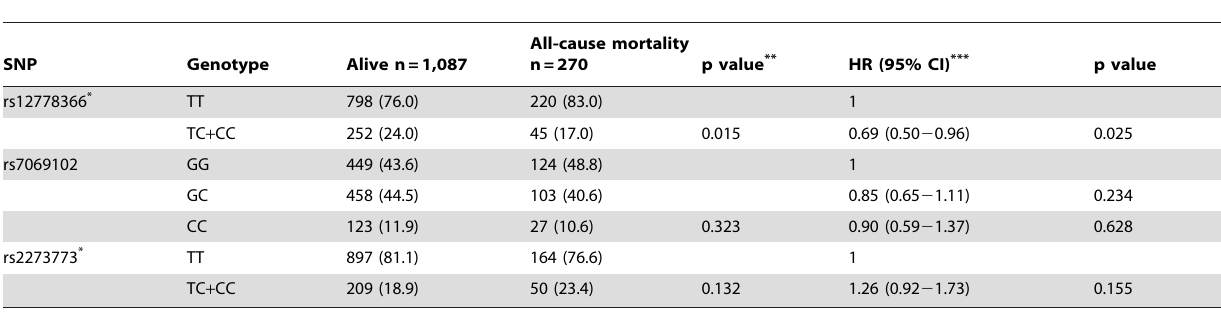
Table 2. Distribution of genotypes and hazard ratio (HR) for all-cause